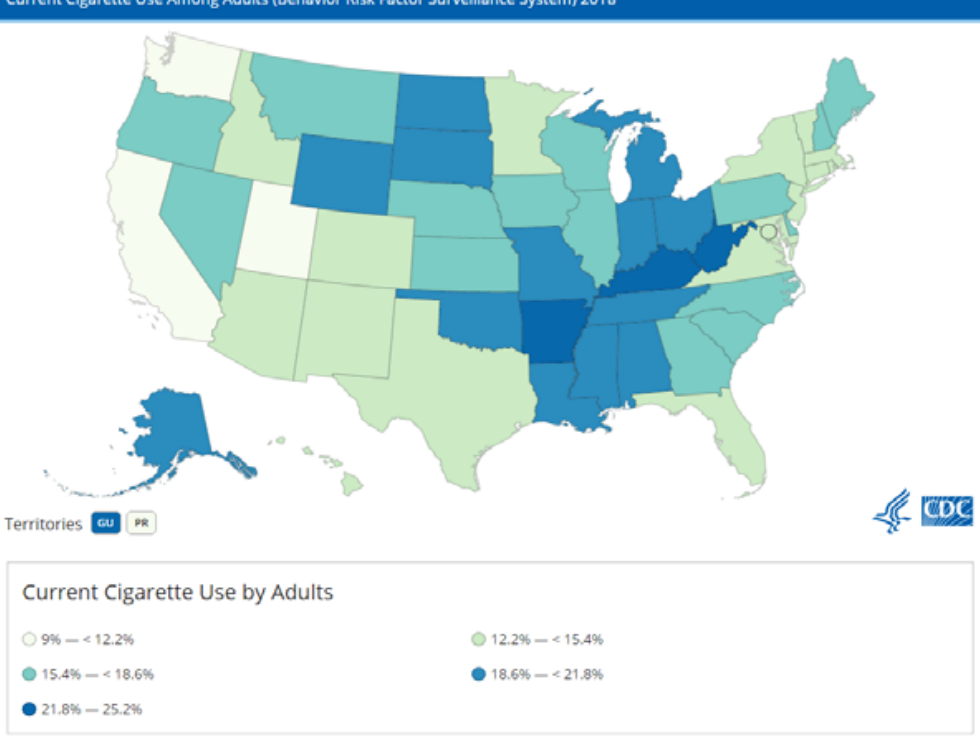
Figure 2. Cigarette Use by Adults, United States, 2018. Source: Centers for Disease Control and Prevention.